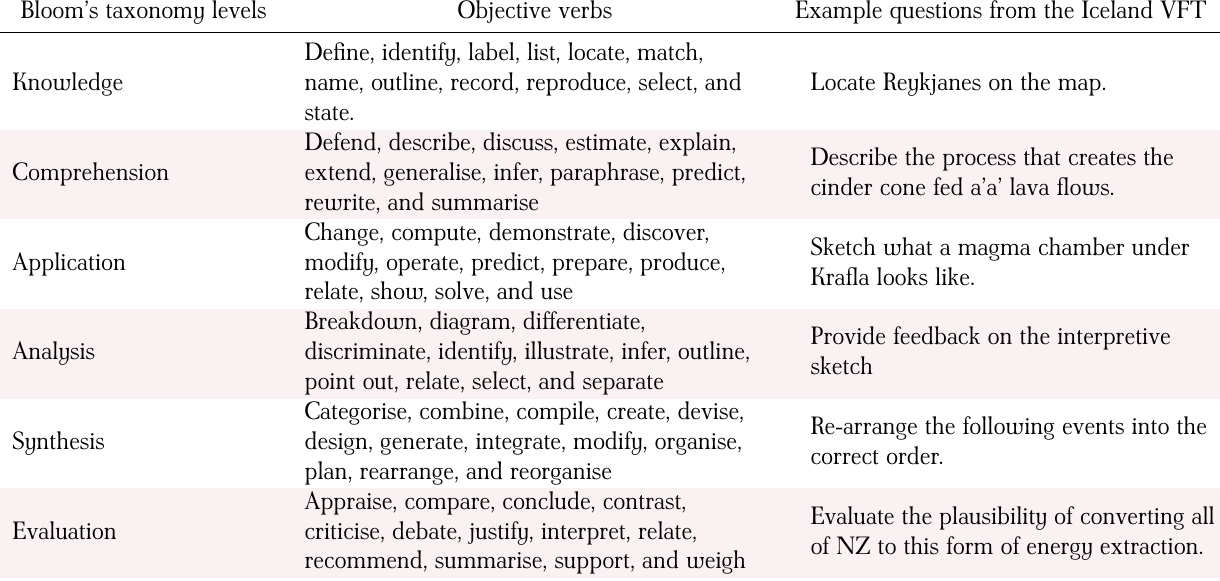
Bloom’s taxonomy